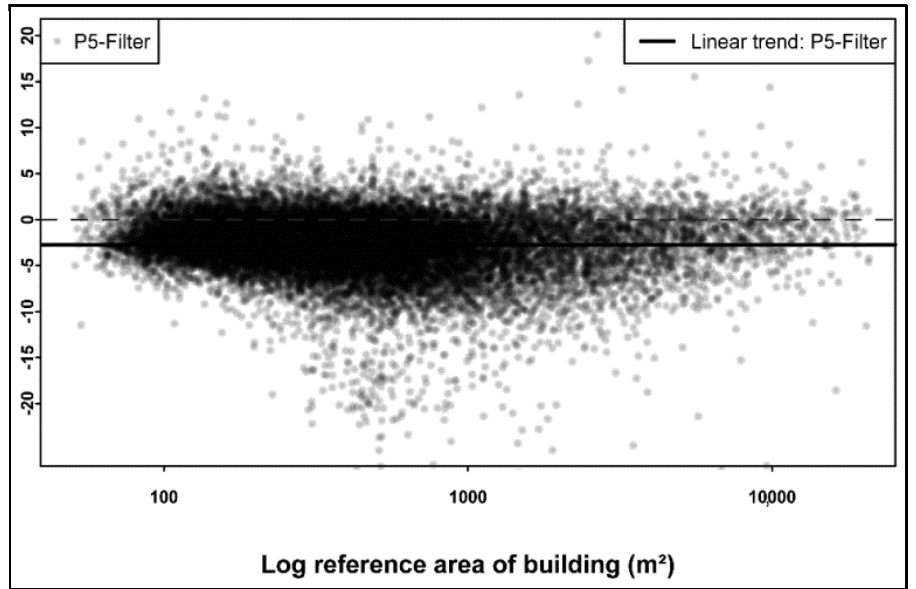
Figure 4. Correlation between building area and the deviation of building height against the reference data.